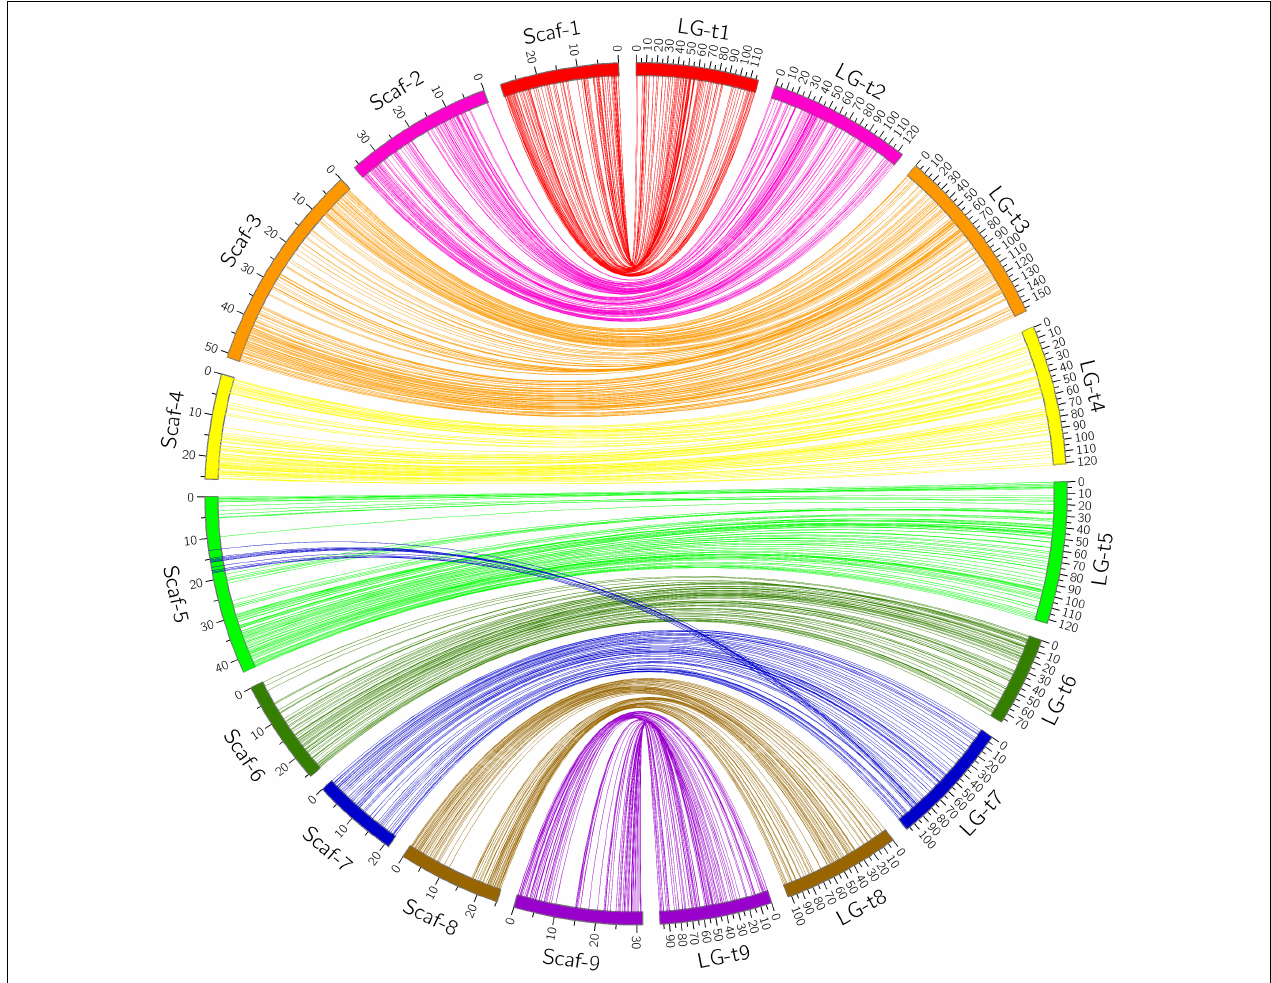
FIGURE 2 | Conservation of synteny and linear order of markers between trifoliate orange genetic map and Clementine mandarin genome via circle diagram.